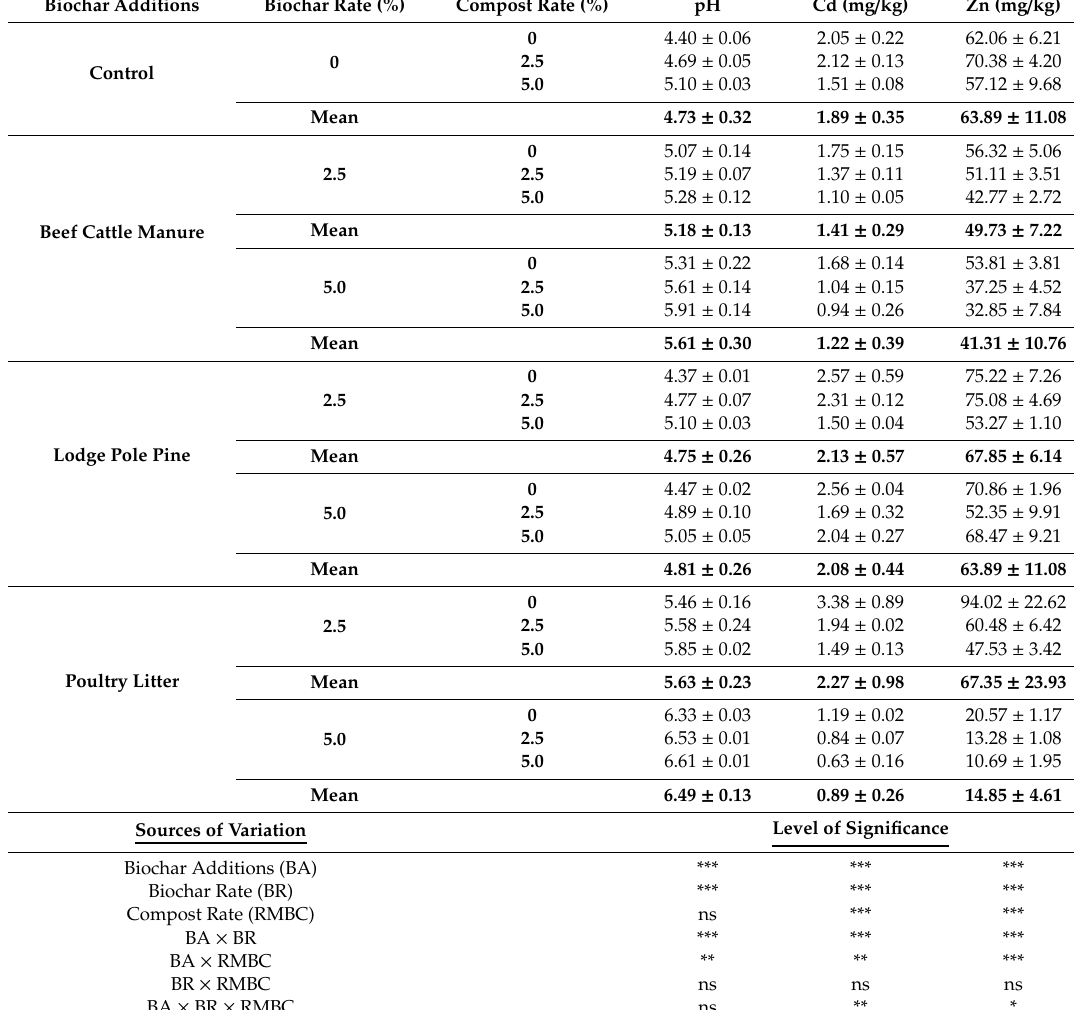
Table 3. Average concentrations of water-soluble Cd and Zn and pH in mine spoil